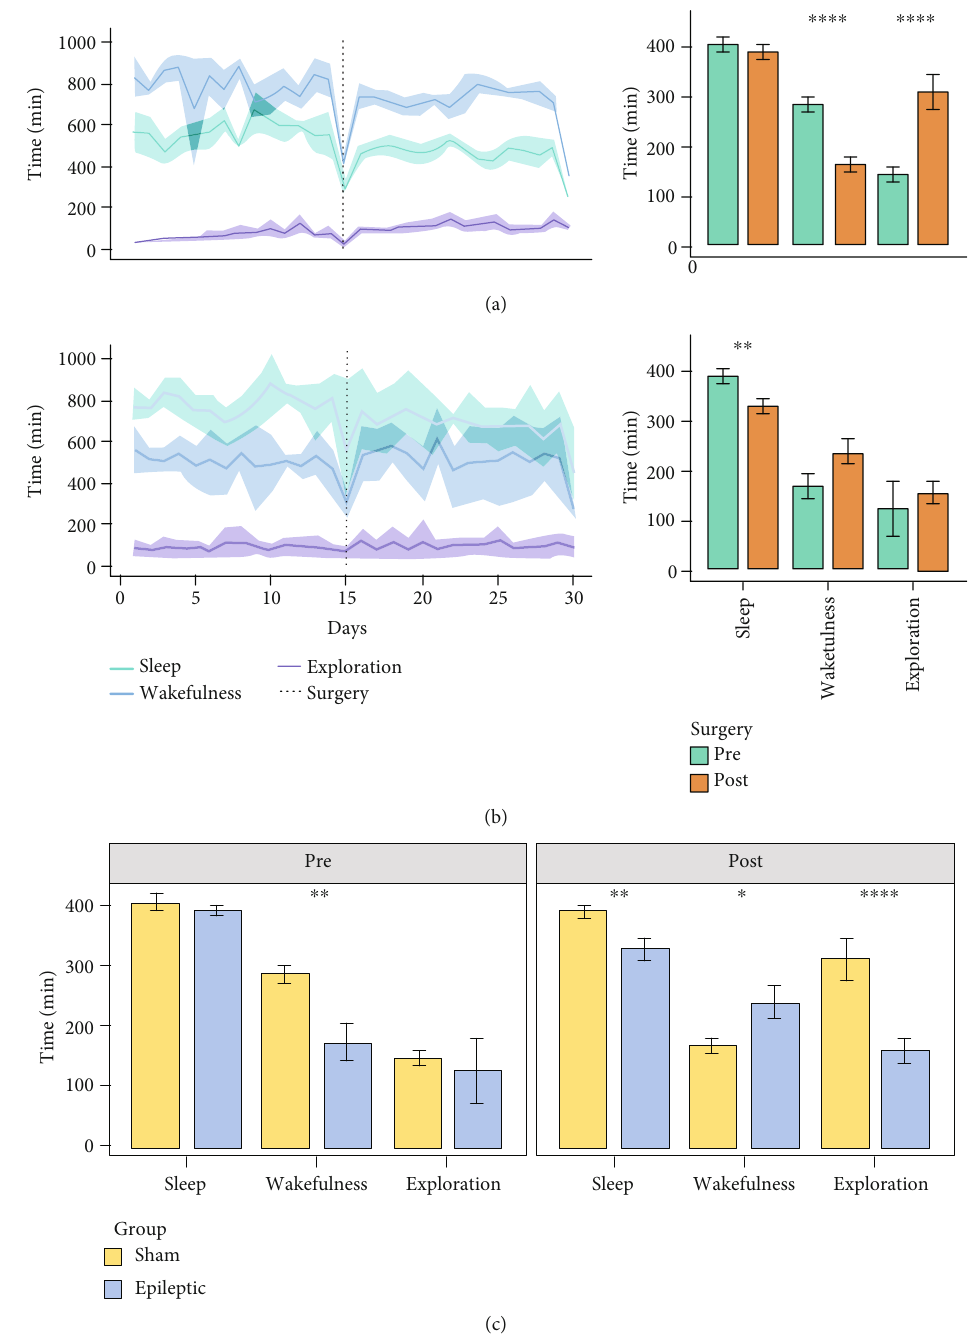
Figure 2: Analysis of physiological behaviours before and after microelectrode implantation surgery. (a) Line plot showing changes in the physiological behaviours of sham animals over time. The solid line represents the sample mean, and the shadowed region indicates the 95% con fi dence interval; comparisons between pre- and postsurgery e ff ects in sham animals are shown at the right. (b) As in (a), but for animals in the epileptic group. (c) Di ff erences in the physiological behaviours of the sham and epileptic groups related to surgery. The t -test was used for each comparison ( ∗ p < 0 : 05 , ∗∗ p < 0 : 01 , ∗∗∗ p < 0 : 001 , and ∗∗∗∗ p < 0 : 0001